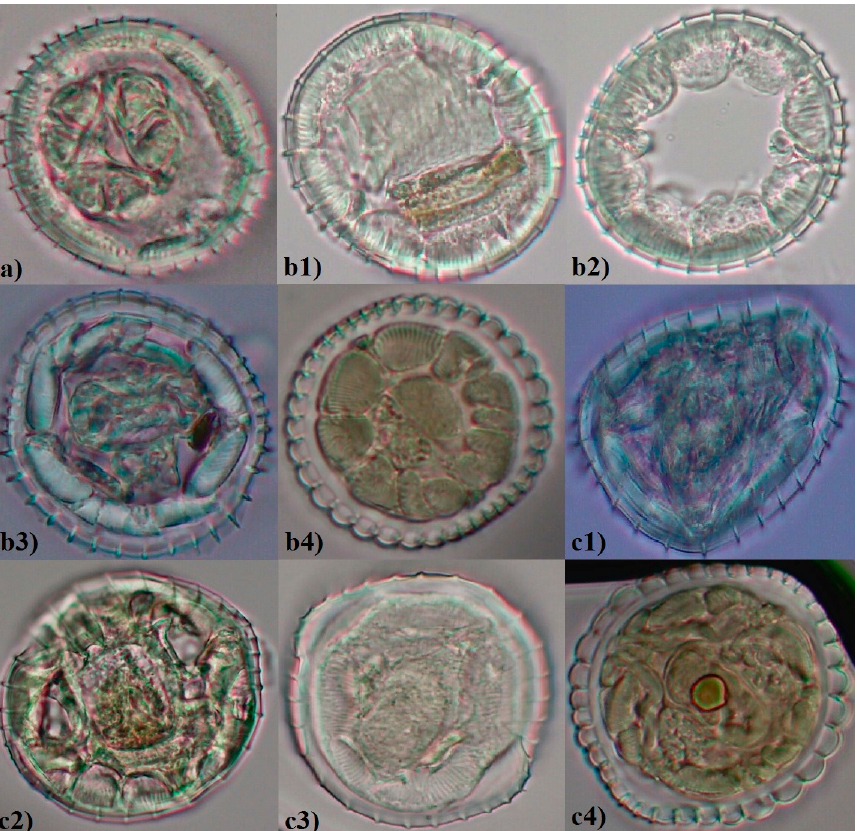
Figure 3. Longitudinal cuticular ridges of Ostertagia leptospicularis males shown in transverse sections ( a ) at the esophageal-intestinal (EI) valves, n = 36, host roe deer ( Capreolus capreolus ); ( b1–4 ) at the midbody: ( b1 ) n = 31, cattle ( Bos taurus ); ( b2 ) n = 32, cattle; ( b3 ) n = 35, red deer ( Cervus elaphus ); ( b4 ) n = 36, roe deer; ( c1–4 ) above the anterior end of the spicules: ( c1 ) n = 30, red deer; ( c2 ) n = 31, cattle; ( c3 ) n = 32, roe deer; ( c4 ) n = 34, roe deer (magnification 600 ×